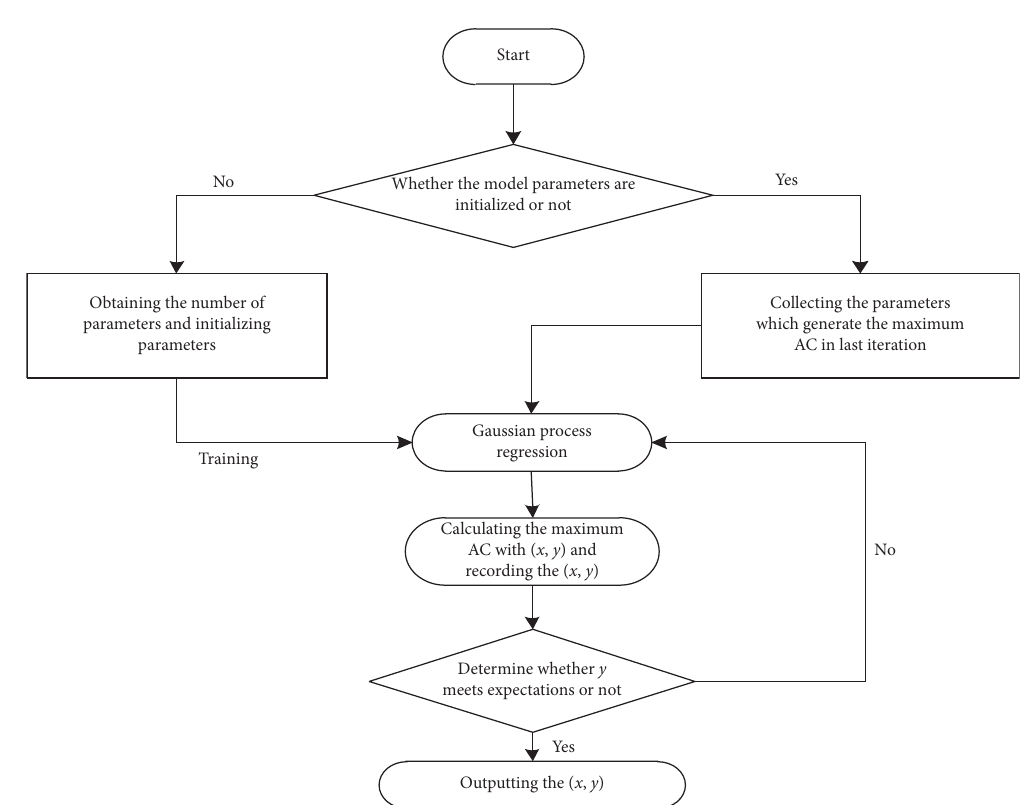
Figure 1: Parameter-tuning process of Bayesian